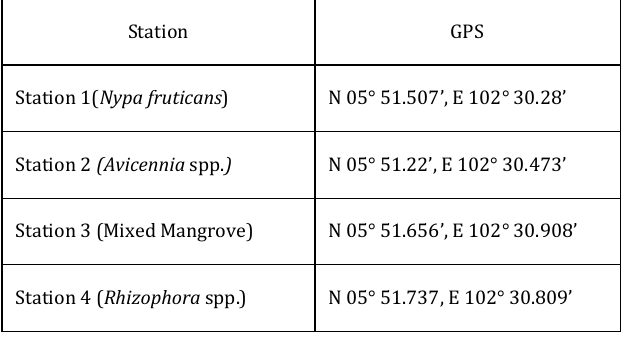
Table 1: Summary of sampling station and the GPS Station